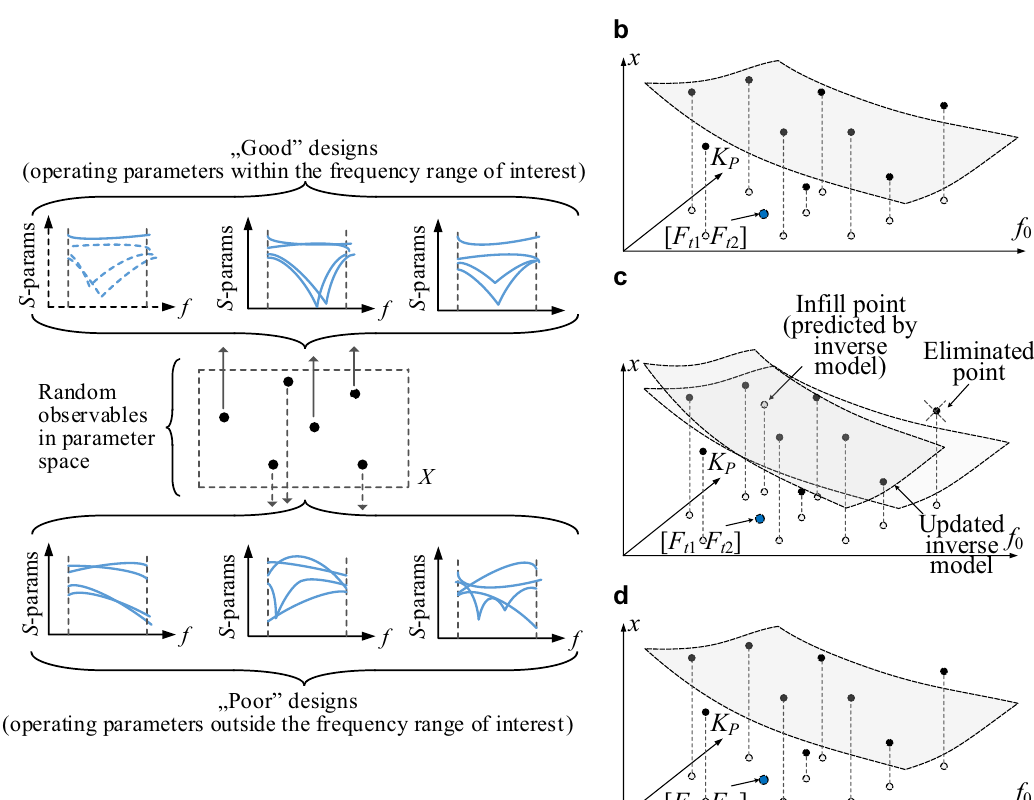
Figure 3. Fundamental components of the proposed optimization procedure: ( a ) selection of the “good” observables, ( b ) observables (•) in the two-dimensional parameter space f 0 , K P for a selected geometry parameter x ; the observable projections onto the f 0 - K P plane, the initial inverse model (grey surface); the target operating parameters (blue circle); ( c ) first iteration: the infill point predicted by r I (grey circle) replaces the worst observable and r I is updated; ( d ) last iteration: the observables concentrated near the target operating parameters and the inverse model yields the design sufficiently close to the